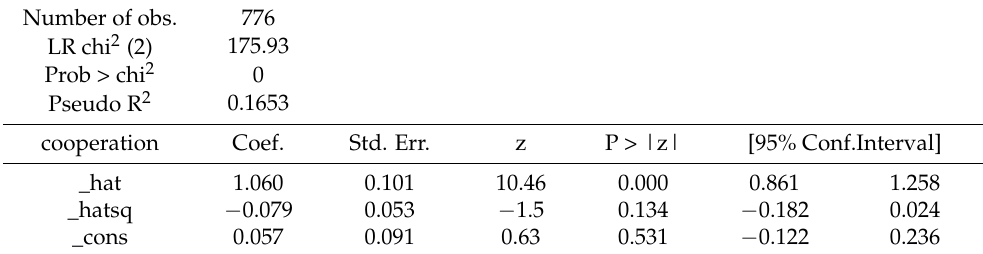
Table 3. Results of linktest. Number of obs.